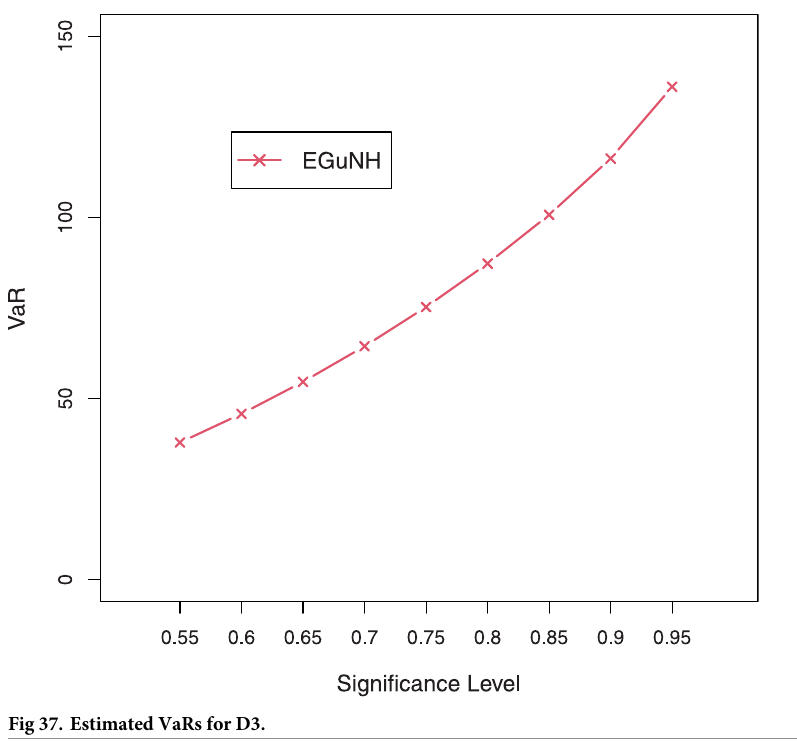
Fig 37. Estimated VaRs for D3.